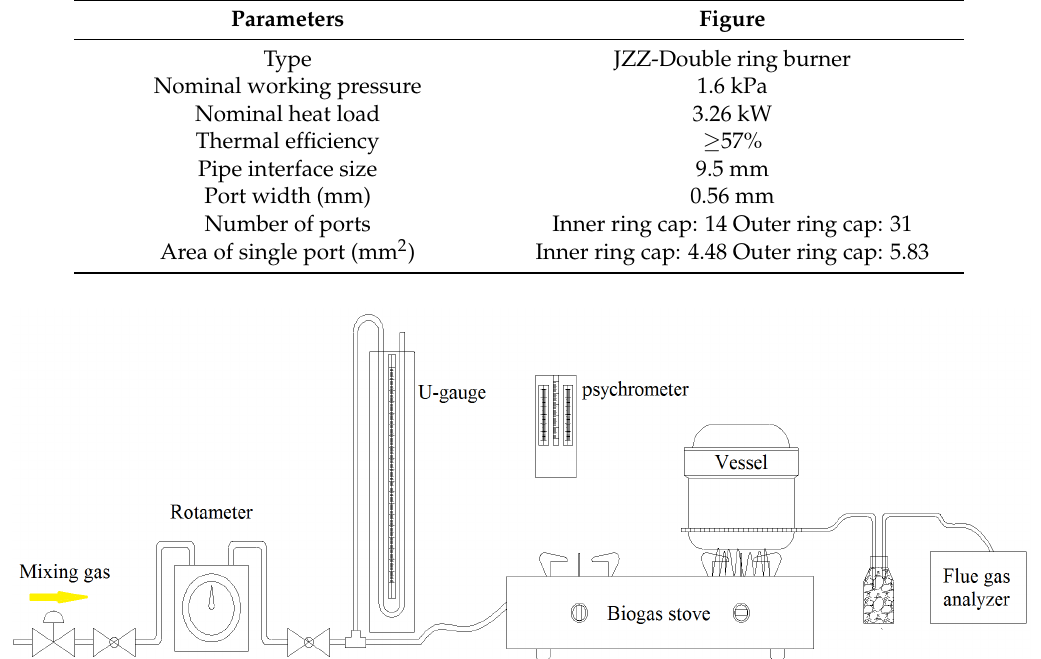
Figure 5. Picture of the domestic swirl burner. Table 4. Detailed specifications of the 6T gas stove used for the experiments.